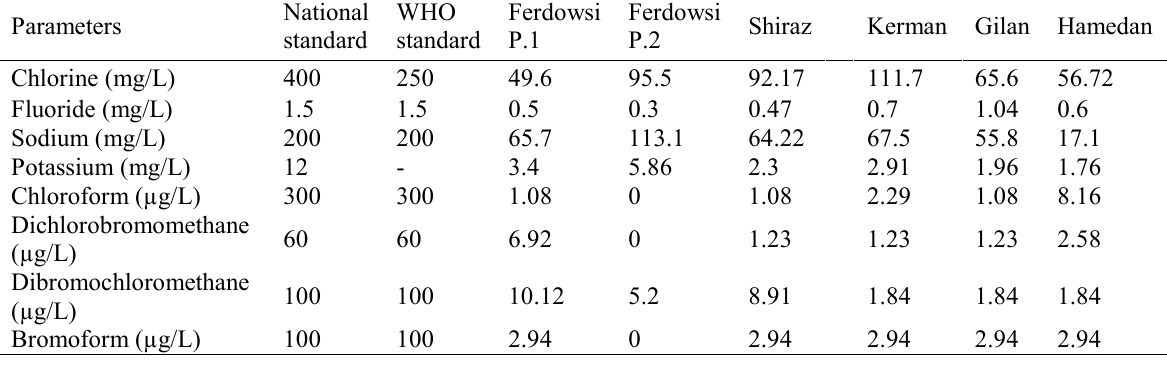
Table 1. Value of chemical parameters of drinking water of universities and its comparison with national and global standard